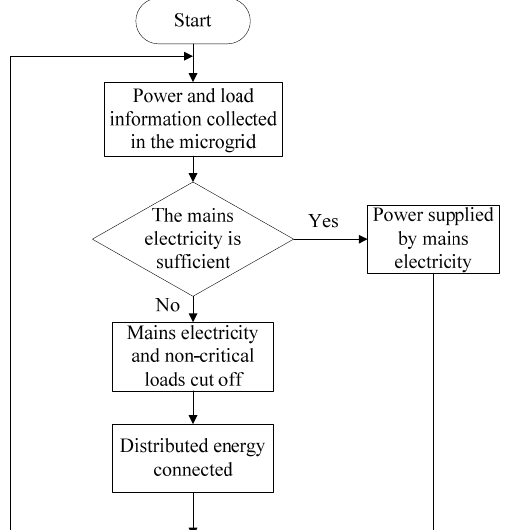
Figure 14. Flowchart of the mains electricity as the primary power supply mode